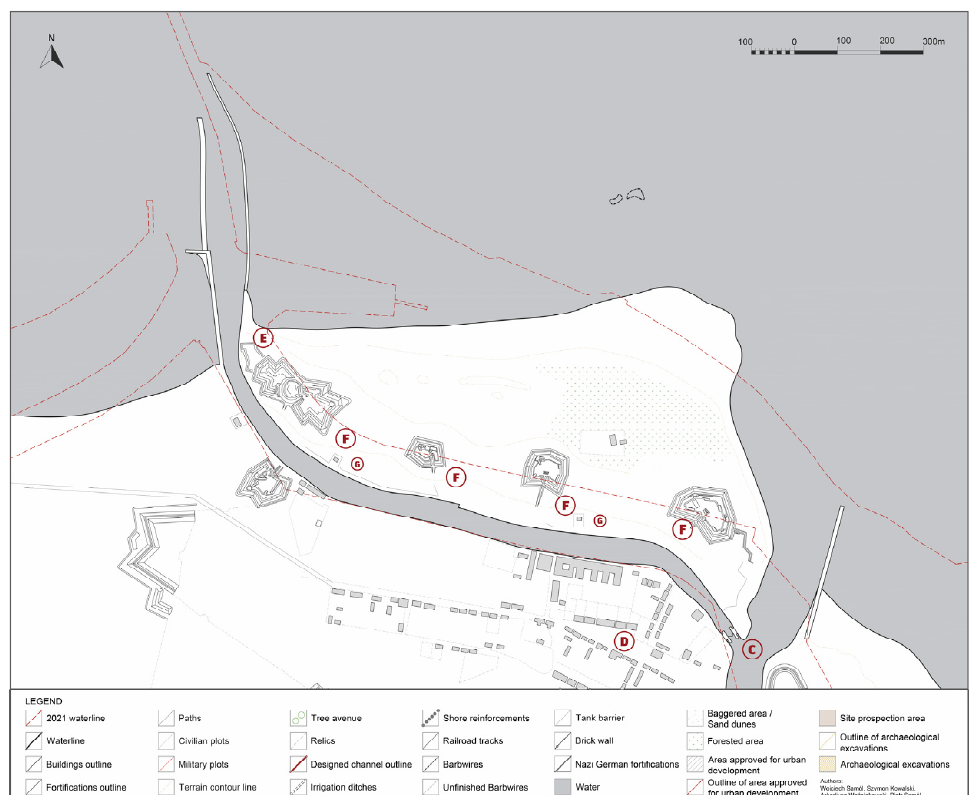
Figure 6. Westerplatte with its Prussian fortifications (in 1812).